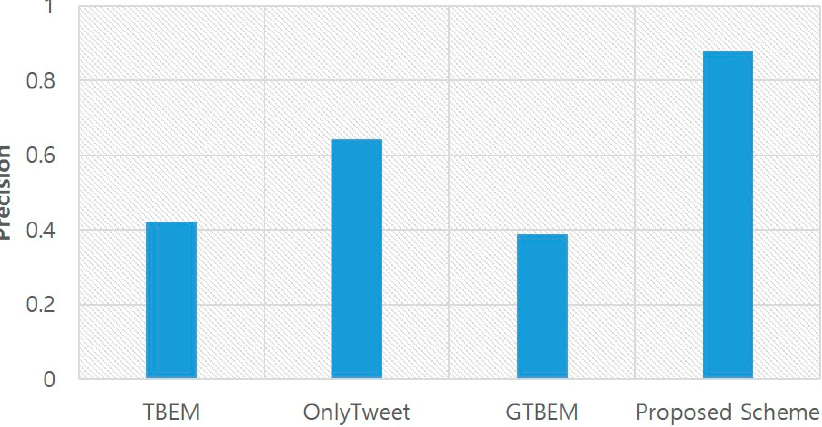
Figure 8. Comparison of precision according to the local event detection schemes.